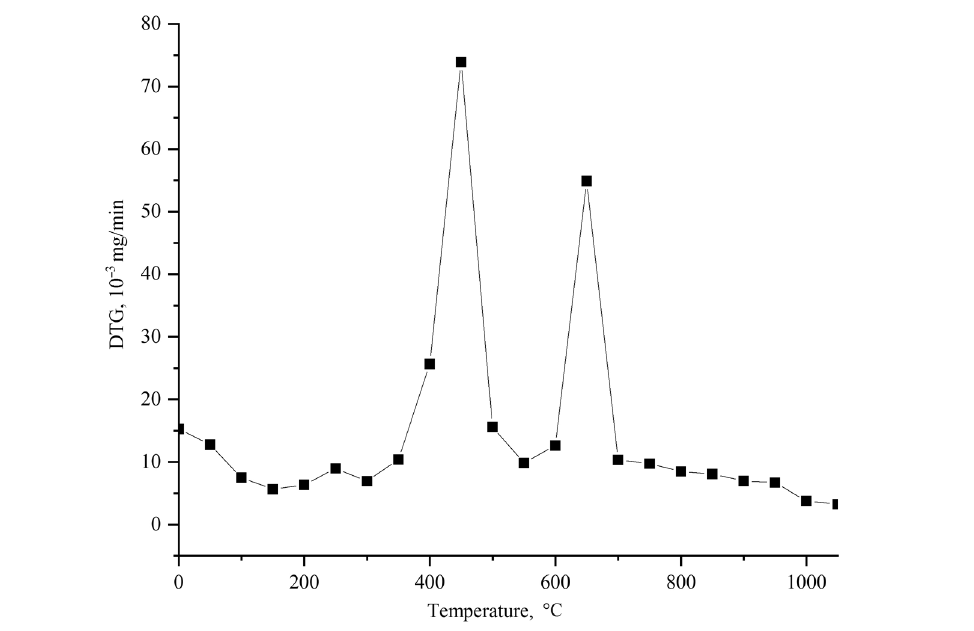
Fig. 3. The DTG curve of Uvurjargalant oil